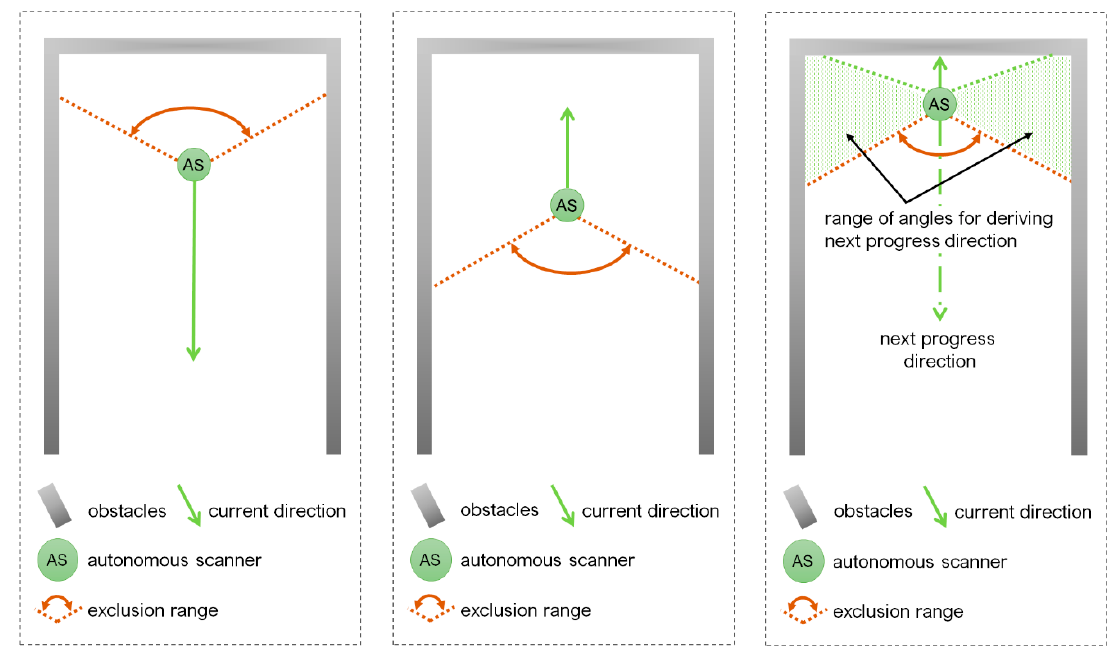
Figure 5. Exclusion of back part of angle corresponding to rotation angle from scan to derive direction for next destination in proposed autonomous driving algorithm.